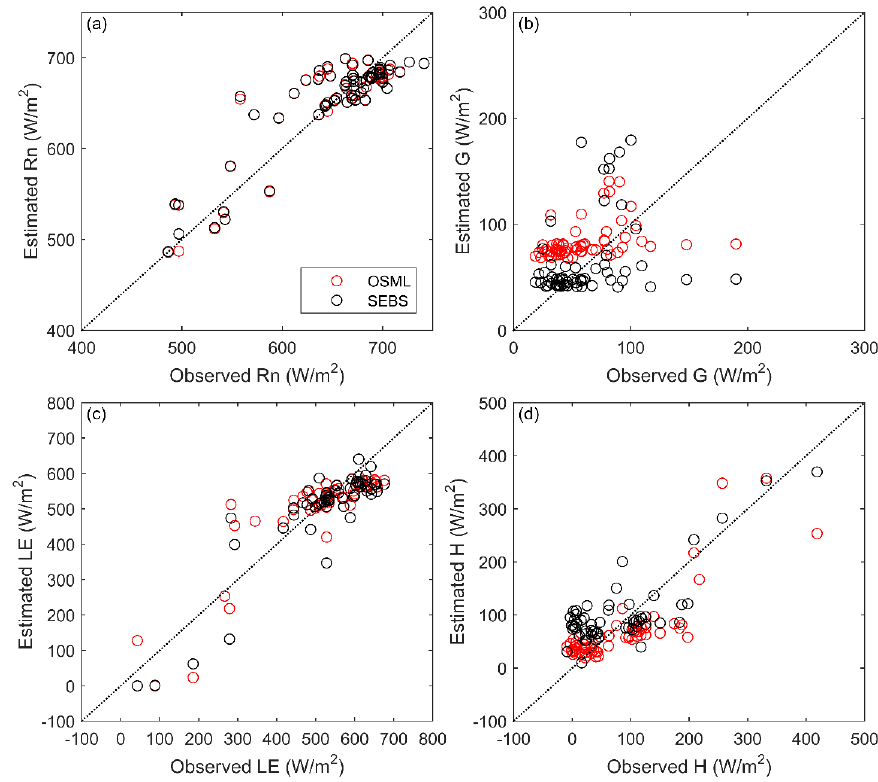
Figure 11. Validation of four energy balance components from OSML using tower-based observations at satellite overpass on DOY 192, DOY 215 and DOY 231 of 2012.